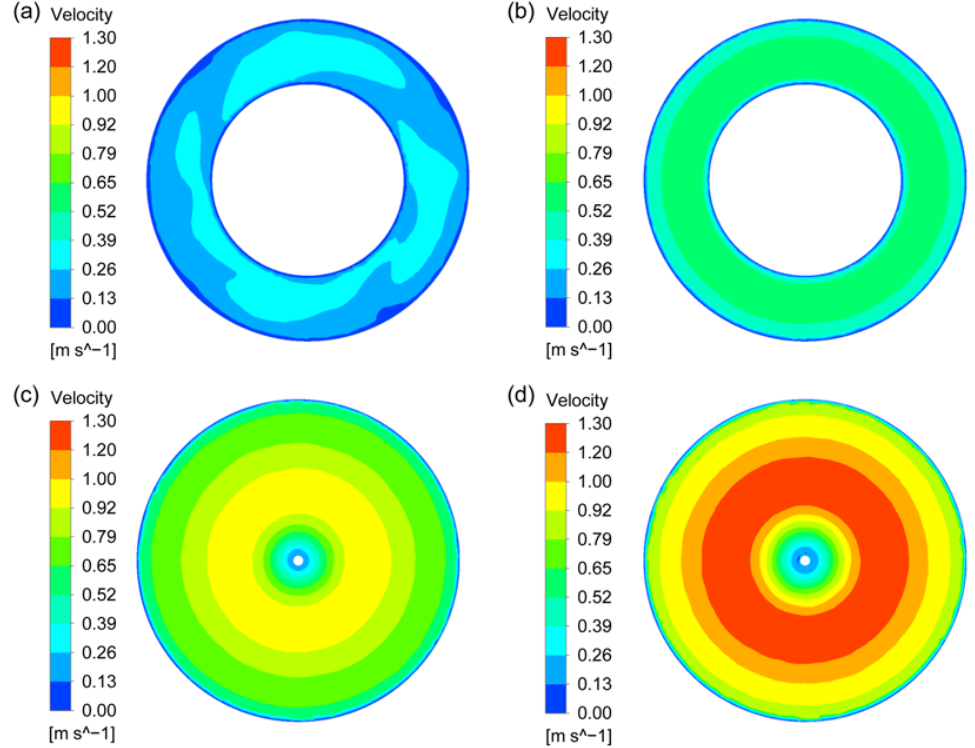
Figure 7. Liquid level velocity for the four types of agitators at the stirring speed of 400 rpm; ( a ) CSRS agitator; ( b ) HCSRS agitator; ( c ) A200 agitator; ( d ) Rushton agitator.